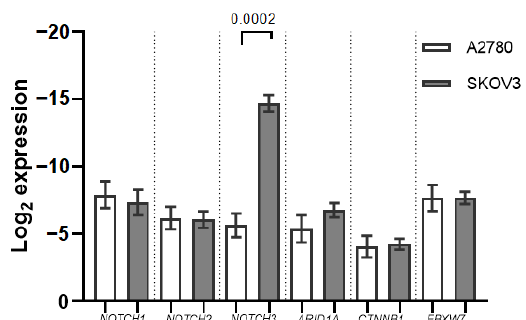
Figure 1. mRNA expression in ovarian cancer (OC) cell cultures A2780 and SKOV3. Boxes indicate the mRNA expression normalized to GAPDH expression data. Whiskers denote standard deviation from the three experimental